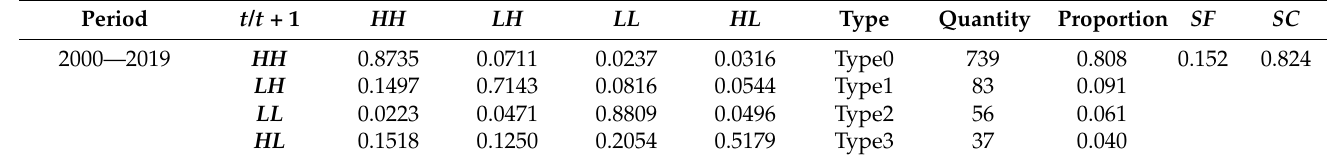
Table 2. Local Moran’s I transition probability matrix of economic spatial polarization in the YRD.